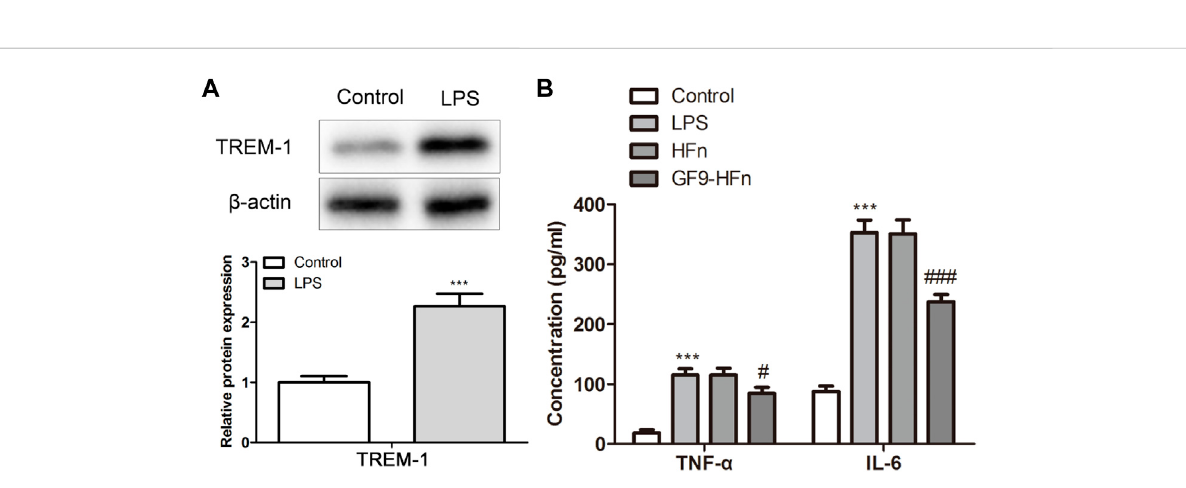
FIGURE 3 The in fl ammatory analysis of nanomedicines. (A) The expression level of TREM-1 was analyzed using a western blot. (B) The levels of in fl ammatorycytokines ofTNF- α andIL-6 wereevaluated.TREM-1, triggering receptorexpressedon myeloid cells-1.TNF- α ,tumor